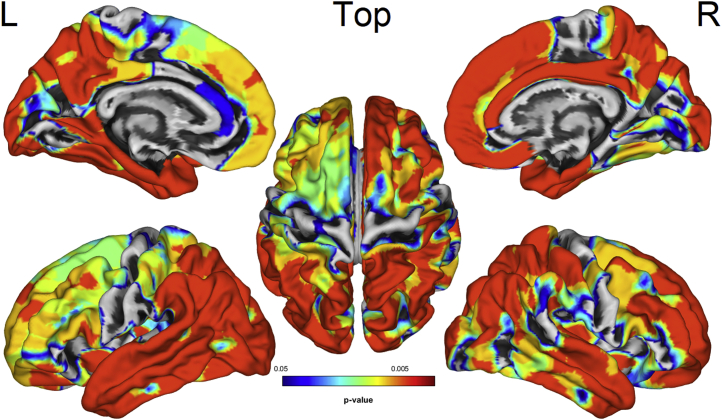
SBM group comparisons showing decreased cortical thickness (blue-red) in the AD/MCI group compared to controls (FDR p < 0.05). Abbreviations: AD, Alzheimer's disease; FDR, false discovery rate; MCI, mild cognitive impairment; SBM, surface-based morphometry; L/R, left/right. (For interpretation of the references to color in this figure legend, the reader is referred to the Web version of this article.)